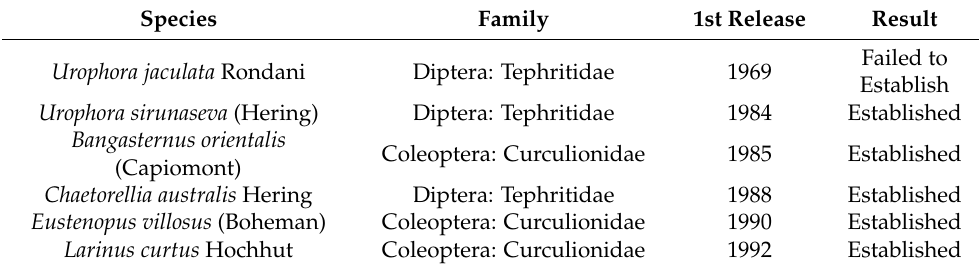
Table 1. List of insect species introduced as biological control organisms on Centaurea solstitialis in the USA. Species Family 1st Release Result Failed to Urophora jaculata Rondani Diptera: Tephritidae 1969 Establish Urophora sirunaseva (Hering) Diptera: Tephritidae 1984 Established Bangasternus orientalis Coleoptera: Curculionidae 1985 Established (Capiomont) Chaetorellia australis Hering Diptera: Tephritidae 1988 Established Eustenopus villosus (Boheman) Coleoptera: Curculionidae 1990 Established Coleoptera: Curculionidae 1992